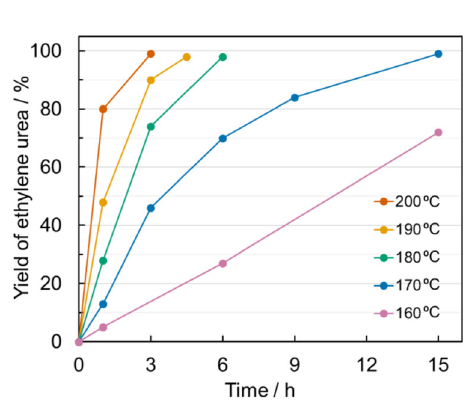
Fig. 3 Effect of reaction temperature. Plot of the NMR yield of ethylene urea as a function of reaction time at various temperatures: 200 °C (red curve), 190 °C (yellow curve), 180 °C (green curve), 170 °C (blue curve), and 160 °C (purple curve). Reaction conditions: 1a (2.0 mmol),